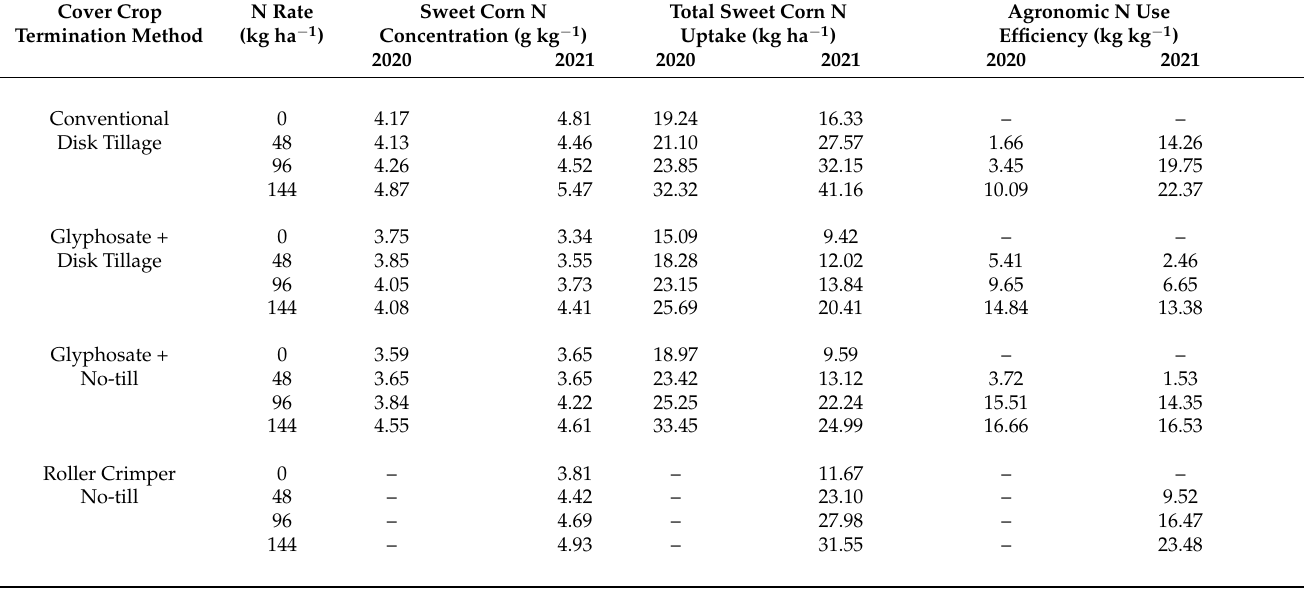
Table 4. Mean sweet corn N uptake and agronomic N use efficiency following different cover crop terminations and N fertilizer rates in South Deerfield, MA.